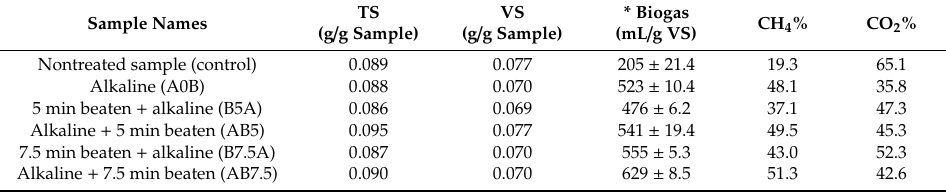
Table 3. Biogas yields following preliminary experiments with nontreated and pre-treated pot ale